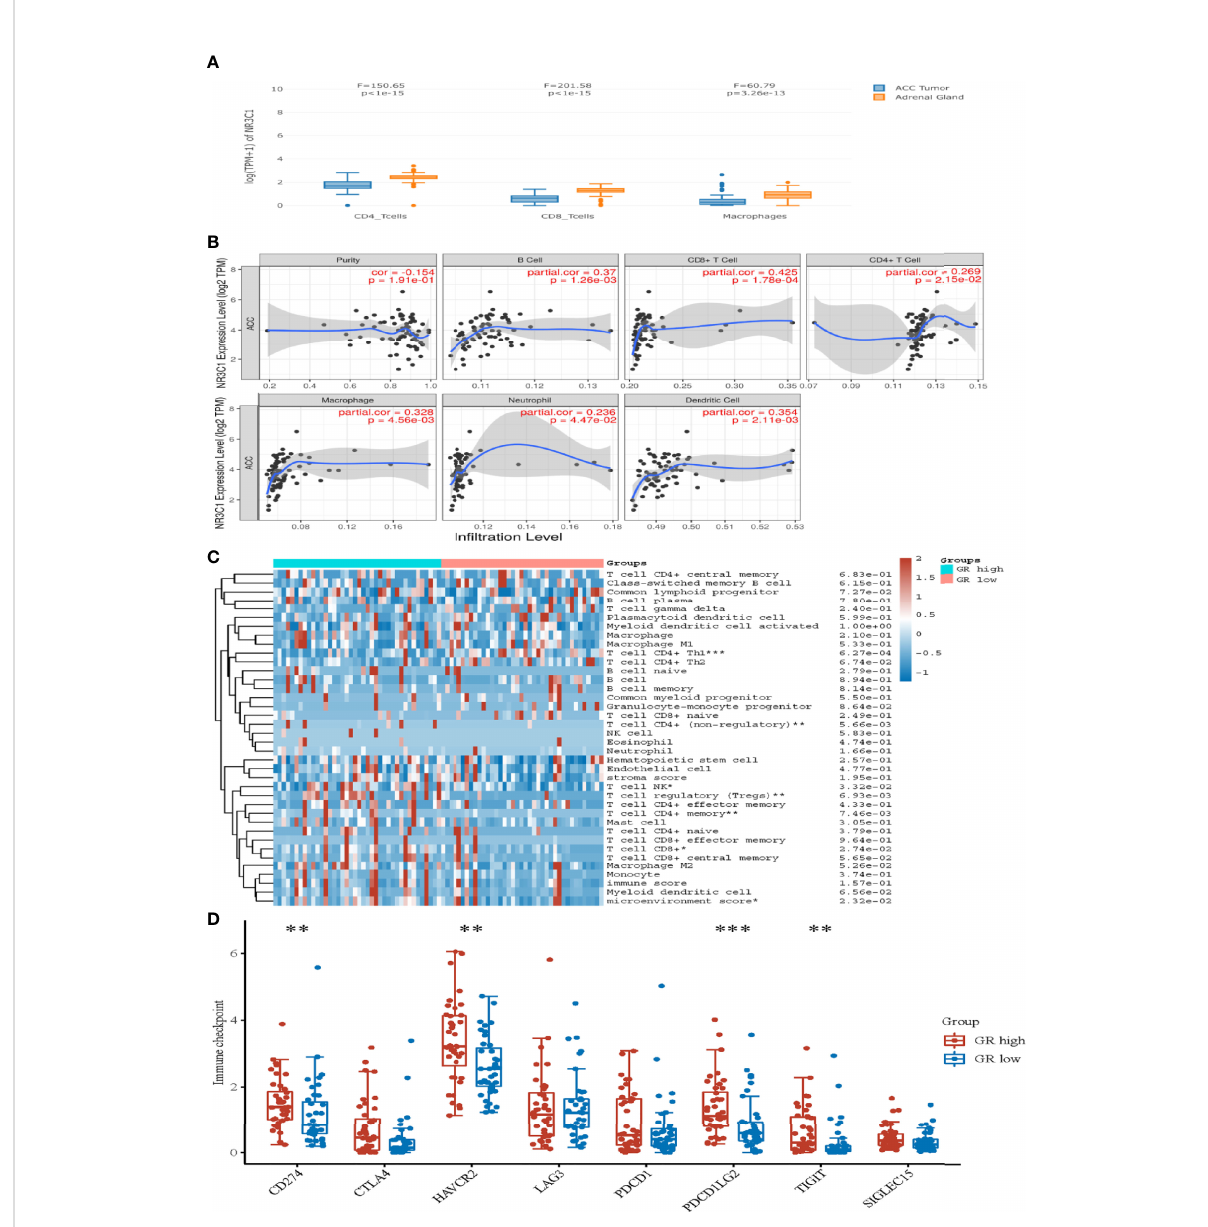
FIGURE 4 The in fl uence of GR mRNA expression on the immune status of ACC. (A) Comparison of GR mRNA expression between CD4+ T cells, CD8+ T cells and macrophages in ACC and normal adrenal glands using publicly available datasets. (GEPIA2021, subexpression analysis, http:// gepia2021.cancer-pku.cn/). (B) The correlation between immune cell in fi ltration and mRNA expression levels of GR in ACC tumors. (TIMER, https://cistrome.shinyapps.io/timer/). (C) Immune cell score heatmap shows the expression distribution of immune score in GR-low ACC and GR-high ACC. (D) The expression distribution of immune checkpoints gene in GR-low ACC and GR-high